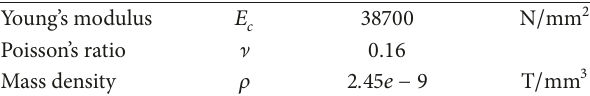
Table 13: Material parameters of concrete for eigenvalue